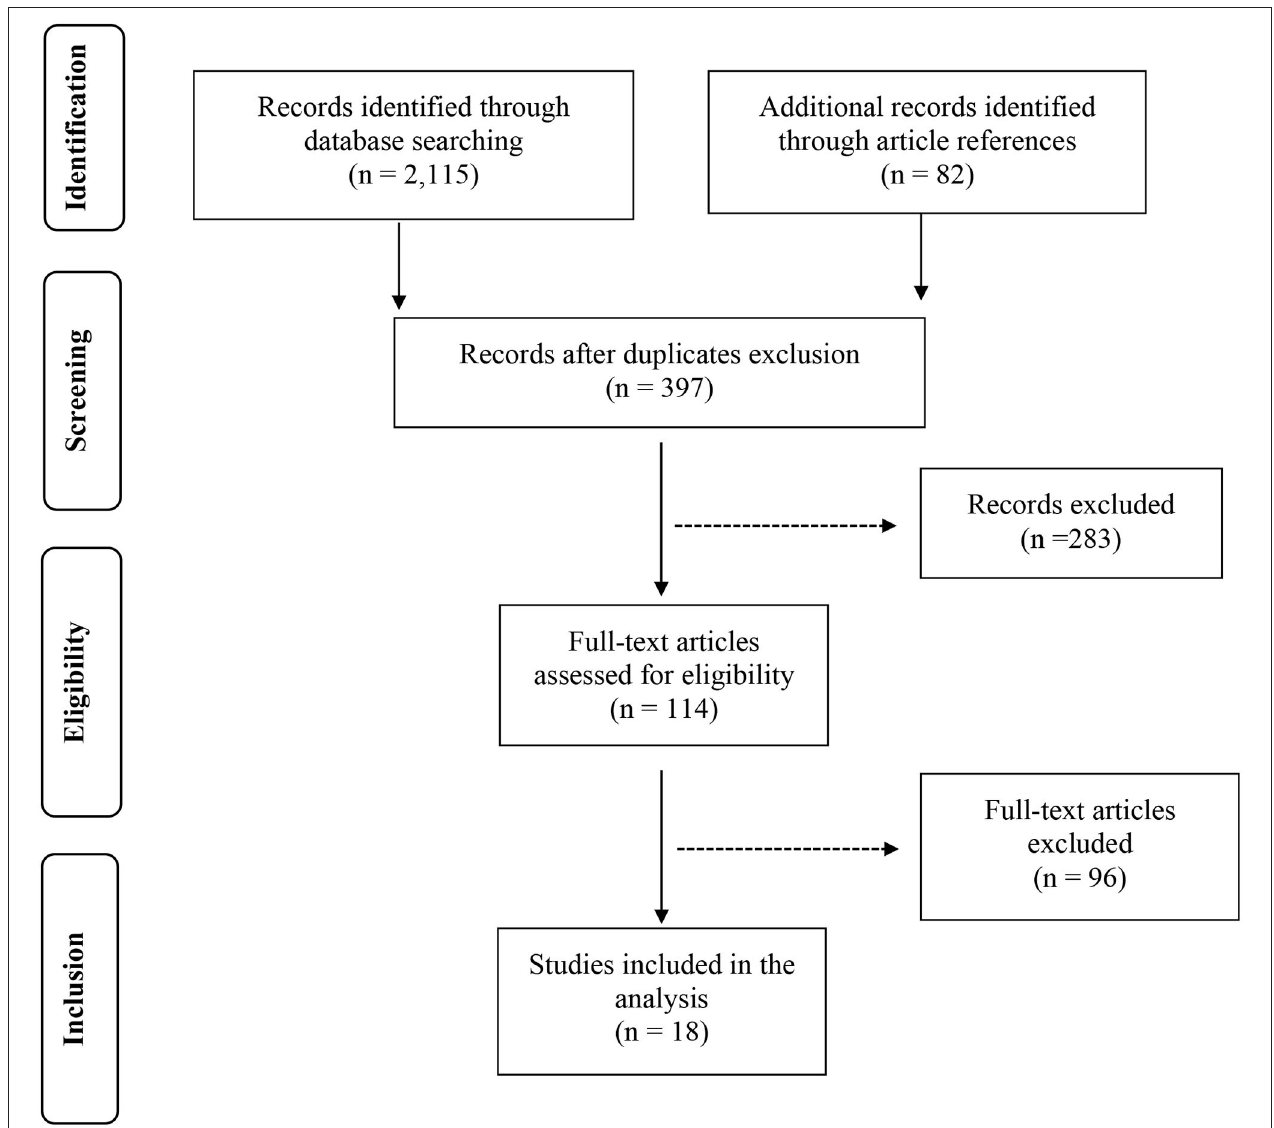
FIGURE 1 | PRISMA flow diagram of the systematic